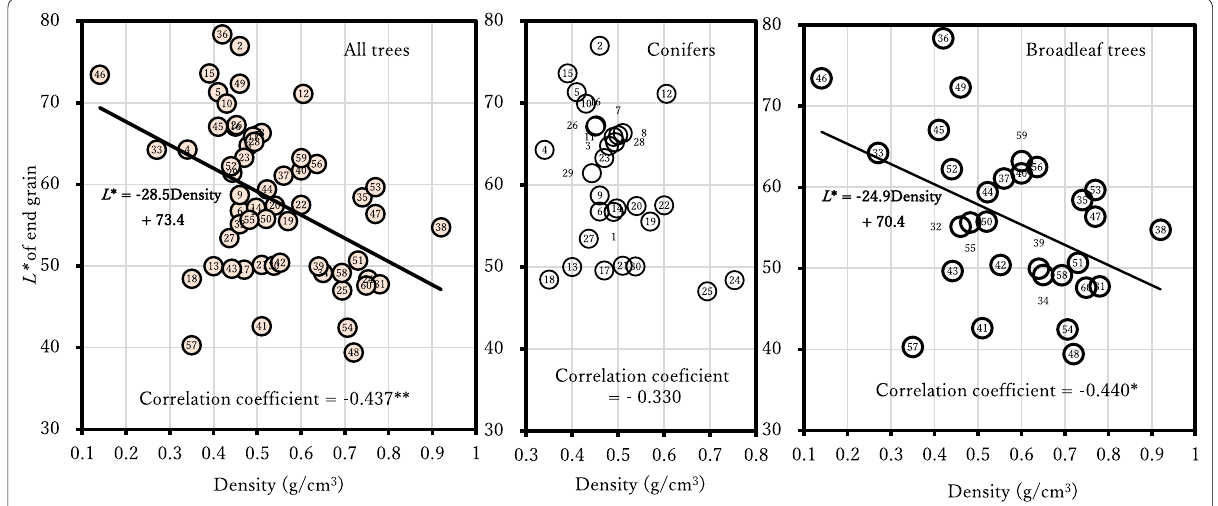
Fig. 8 Correlation diagrams between density and L* of end grain of each test piece. Each test piece number is shown as in Tables 1 and 3